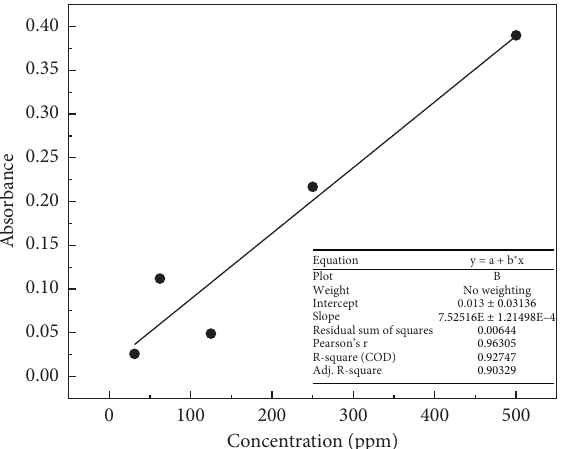
Figure 15: Calibration curve (linear fitting) for determination of chromium